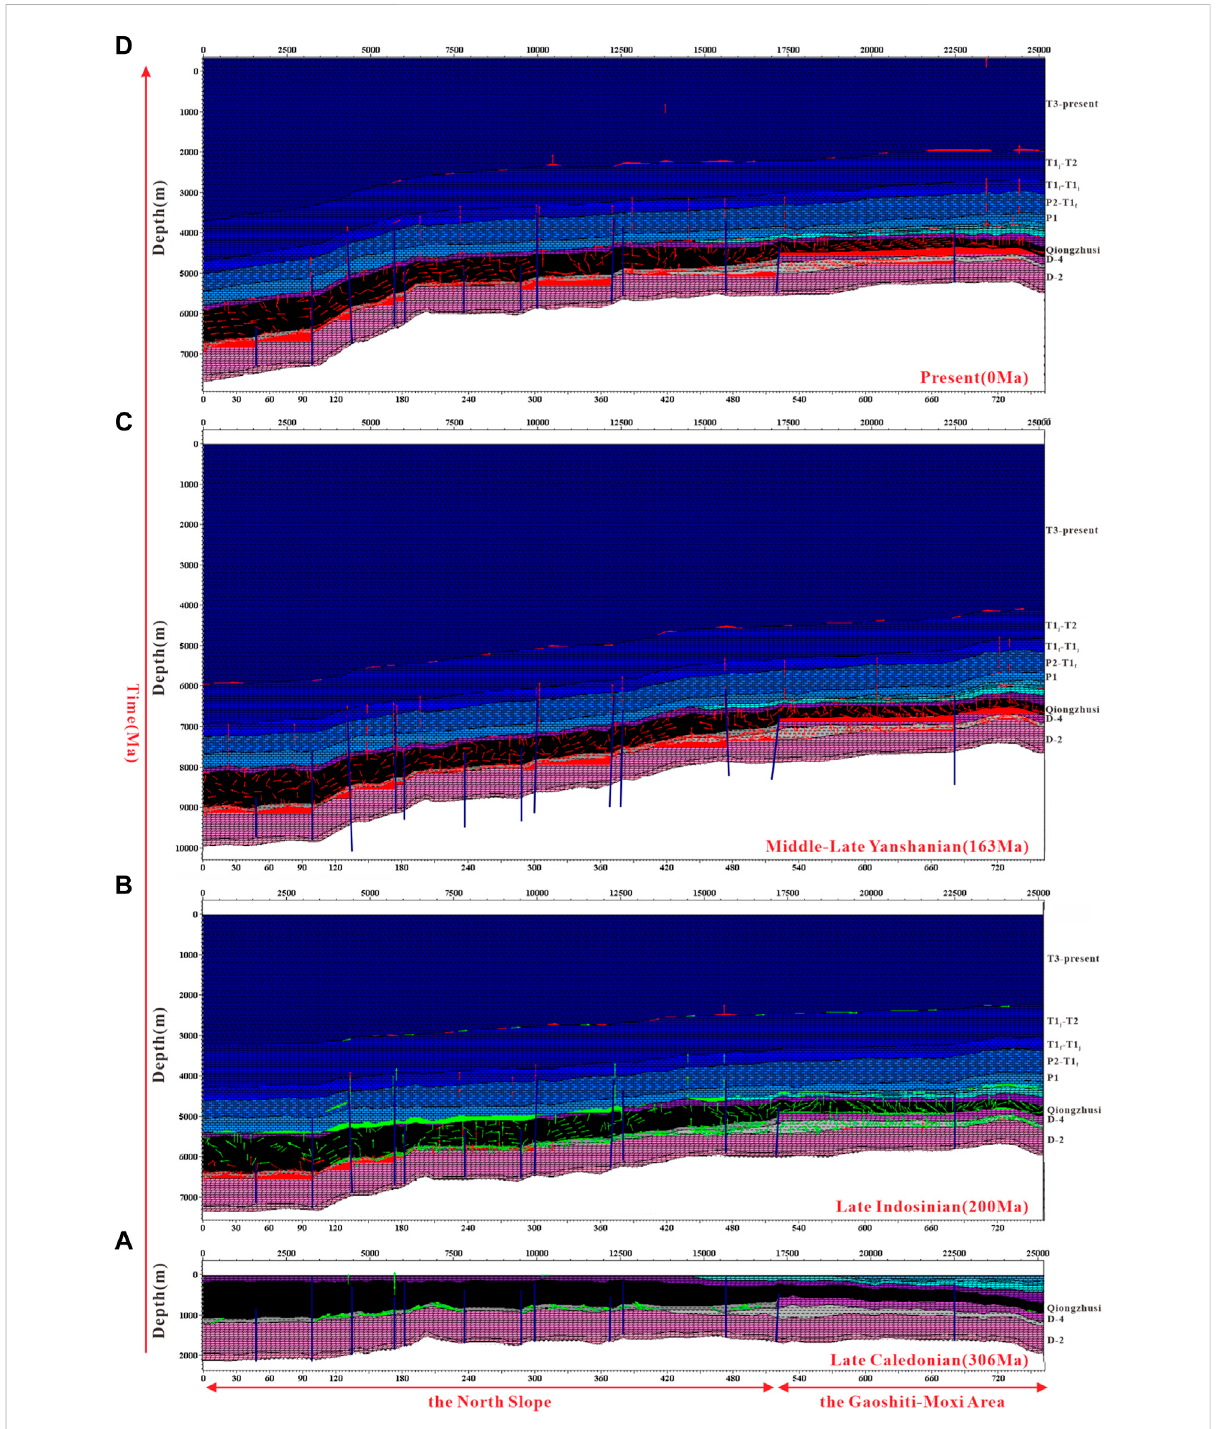
FIGURE 13 Two-dimensionalsimulationforthecomparisonoftheformationandevolutionofSiniangasreservoirsindifferentblocksofthecentralSichuan Basin. (A) In late Caledonian, oil started to accumulate on the North Slope. The Dengying strata in all regions were relatively gentle. (B) In late Indosinian, a large amount of oil was generated and migrated laterally and horizontally to reservoirs. Oil of the Dengying reservoirs in Zhongjiang blockcrackedintogasduetoadeeperburial depth.TheDengying stratainall regionsremainedrelativelygentle. (C) Inmiddle-lateYanshanian, due to the rapid subsidence of the North Slope, the strata then dipped north. The Gaoshiti-Moxi area gradually became an uplift area. Almost all the oil reservoirs cracked, and gas migrated upwards and laterally. (D) The present gas reservoir pro fi le shows the gas reservoirs ’ potential